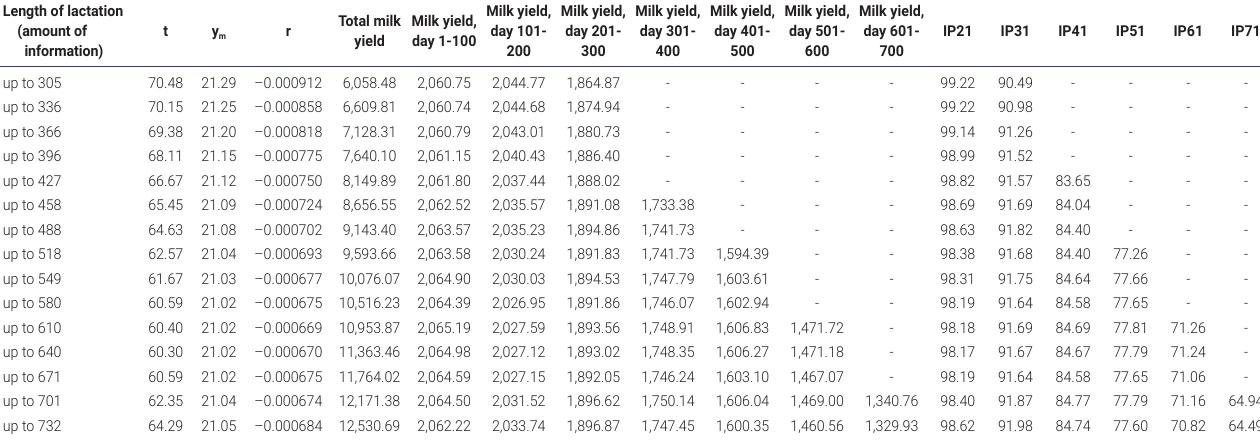
Table 4. Characteristics of lactation according to the assessed parameters of Wood’s model Length of lactation (amount of